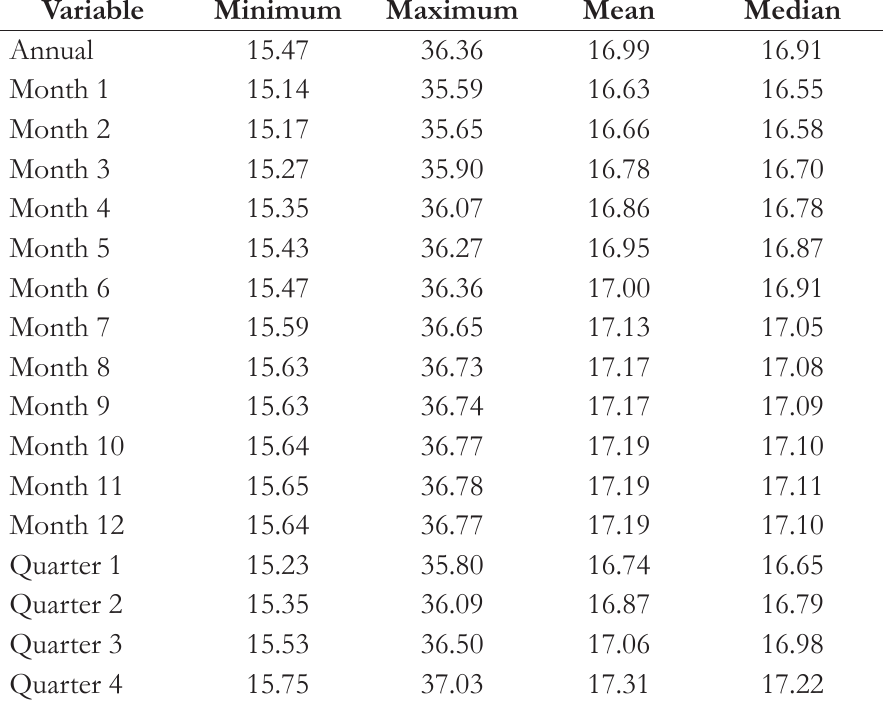
Table 2. Summary of the Annual, Monthly and Quarterly Weights created to Project the US Population